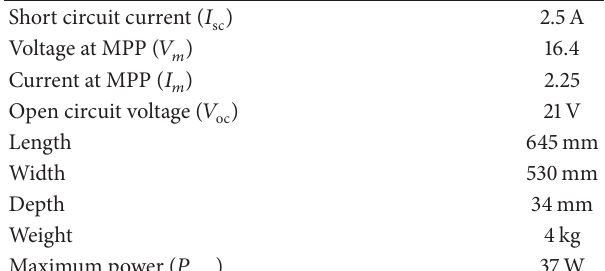
Table 1: Specifications of L1235-37W solar PV panel.